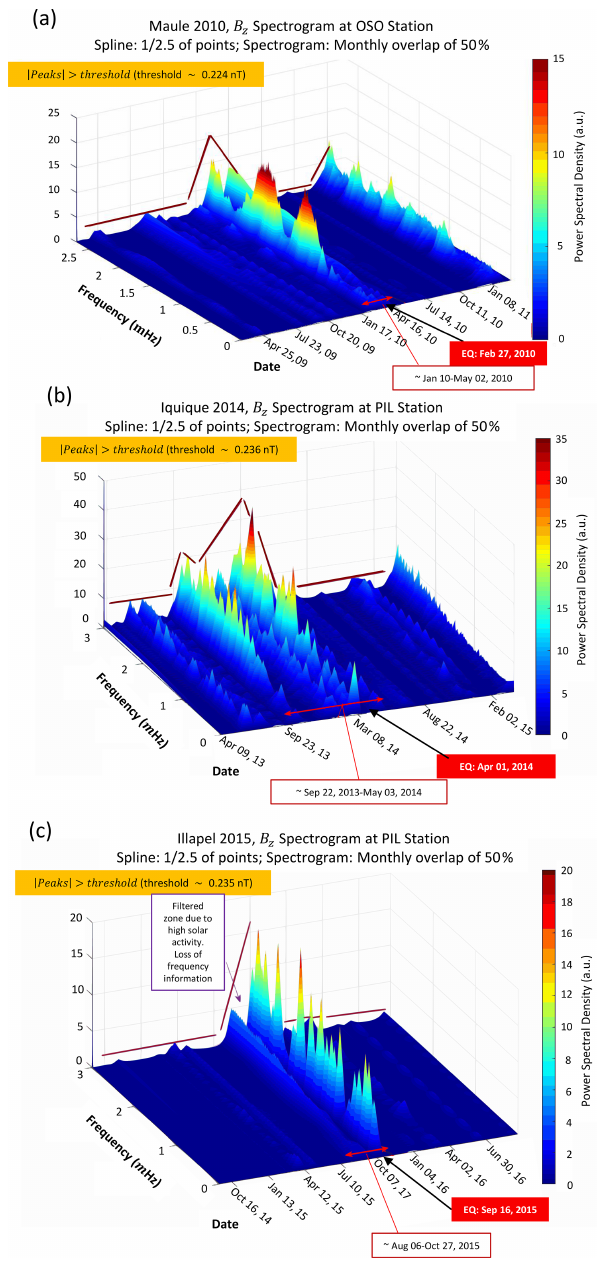
Figure 6. Spectrogram analysis of vertical magnetic components after the external influence is filtered. (a) The rise in a range of fre- quencies (1–2.5mHz) appears prior to and after the Maule 2010 earthquake (OSO station). The active frequencies last less than 3 months. (b) The rise in similar frequencies appears prior to the Iquique 2014 earthquake in the vertical component of the PIL sta- tion. This frequency activity lasts more than 5 months. (c) The solar events are intense during September 2015. Nevertheless, this can be seen as an increase in the spectrum since August 2015. This fre- quency activity lasts close to 3 months. Three earthquakes hit when the rise in ultra-low frequencies (mHz) exists. Note that Iquique is not filtered by Dst as Maule and Illapel